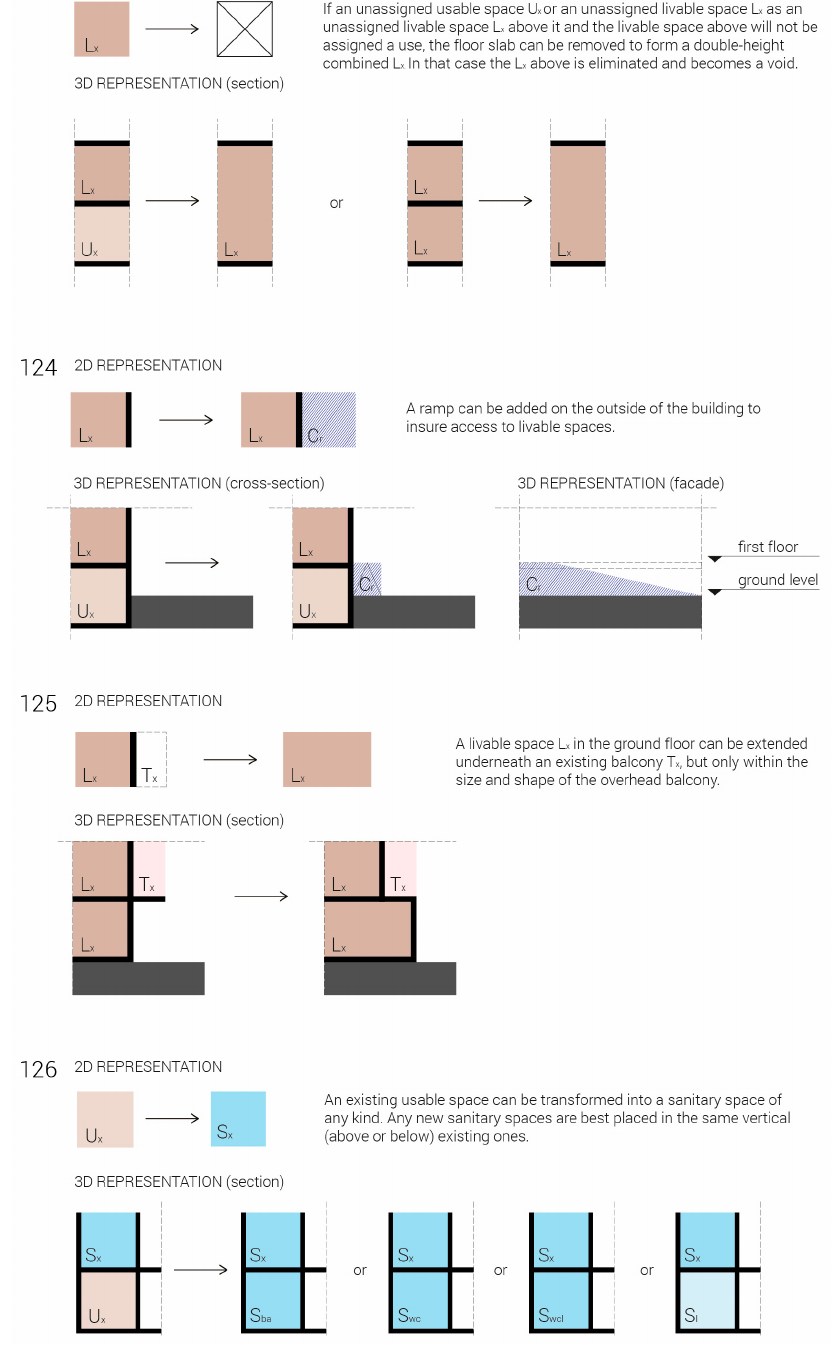
Figure 17. 3D rules 123–126 (Ana Bel č i č , 2022).